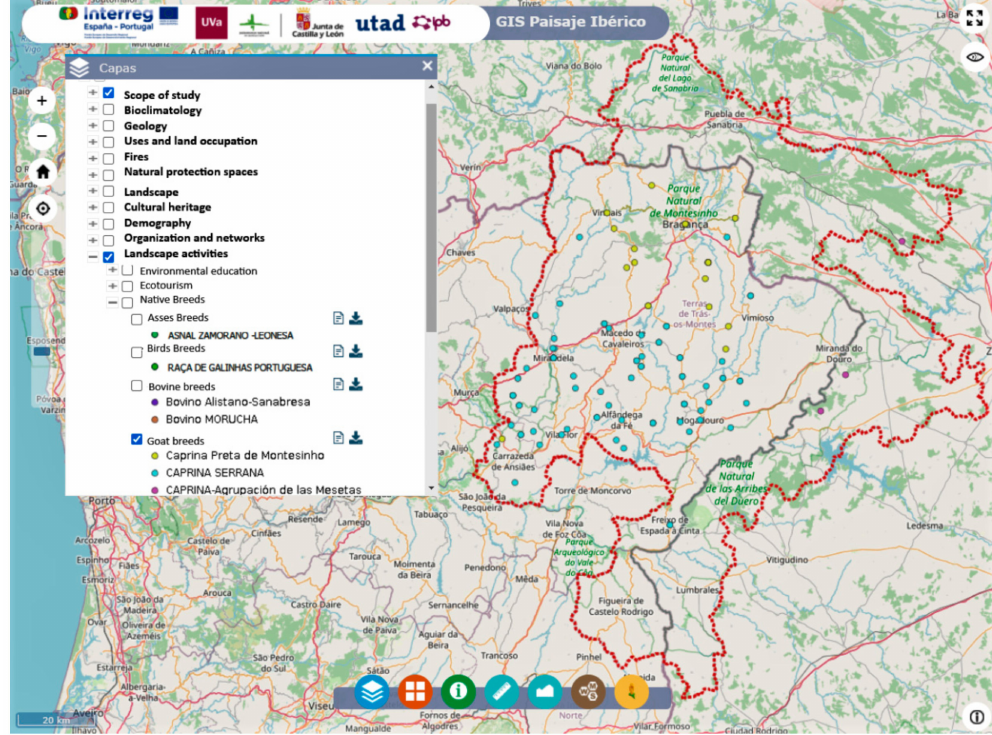
Figure 5. Location map of native goat breed